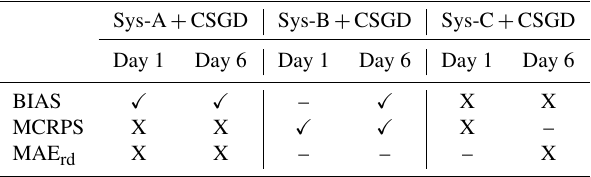
Table 5. Synthesis of the best options available for a forecast user when partial uncertainty quantification systems (A, B, and C) with a precipitation post-processor are compared against a full uncertainty quantification system D without a post-processor in terms of BIAS, overall quality, and reliability for days 1 and